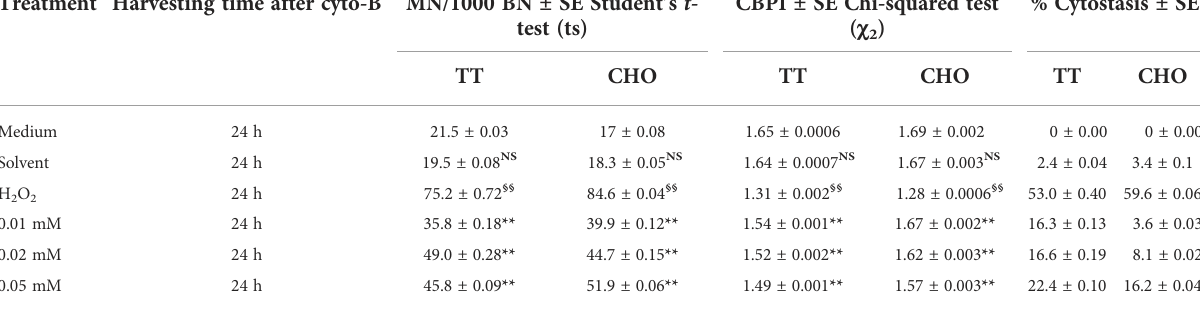
TABLE 2 Induction of micronuclei (MN), cytokinesis-block proliferation index (CBPI), and % of cytostasis in TT and CHO cell lines treated for 24 h with